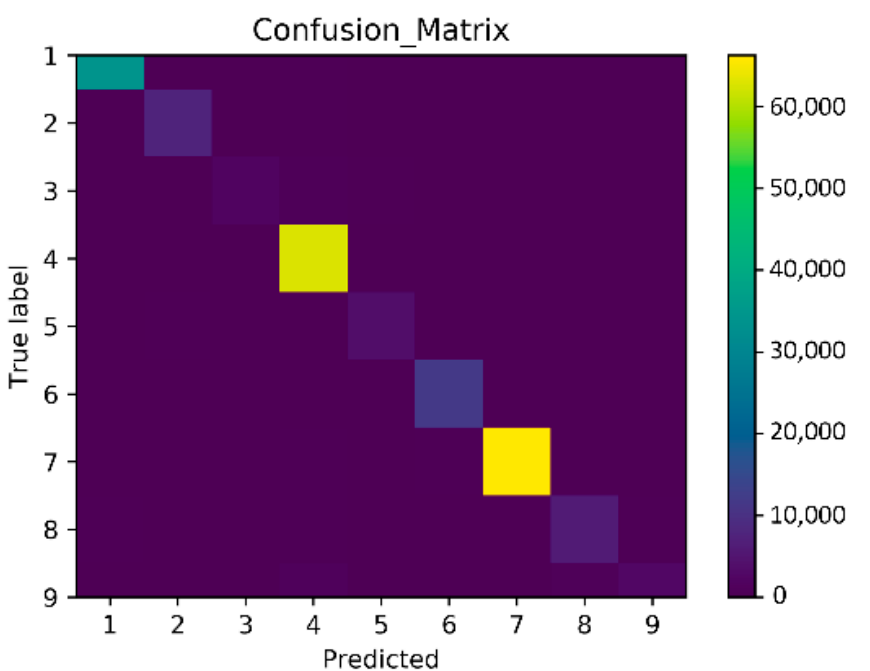
Figure 9. The predicted classification map for 0.1% samples from the WHU-Hi-LongKou dataset with the method of ( a ) 2D-CNN, ( b ) M3D-CNN, ( c ) HybridSN, ( d ) R-HybridSN, and ( e ) MSPN and ( f ) ground truth.